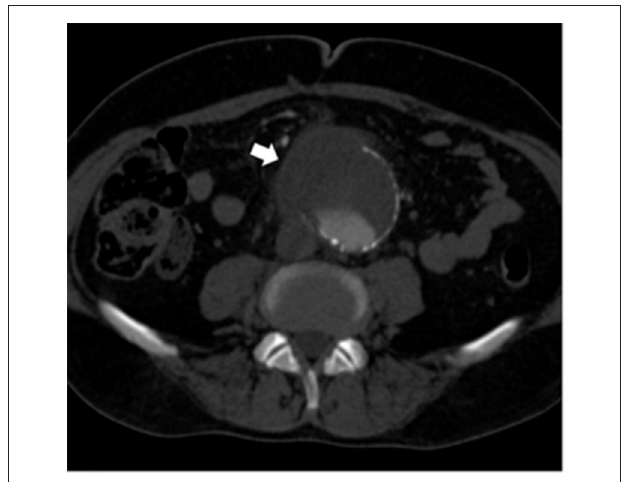
FIGURE 1 | Preoperative CT scan showing an abdominal aortic aneurysm surrounded by inflammation/fluid collection (white arrow).